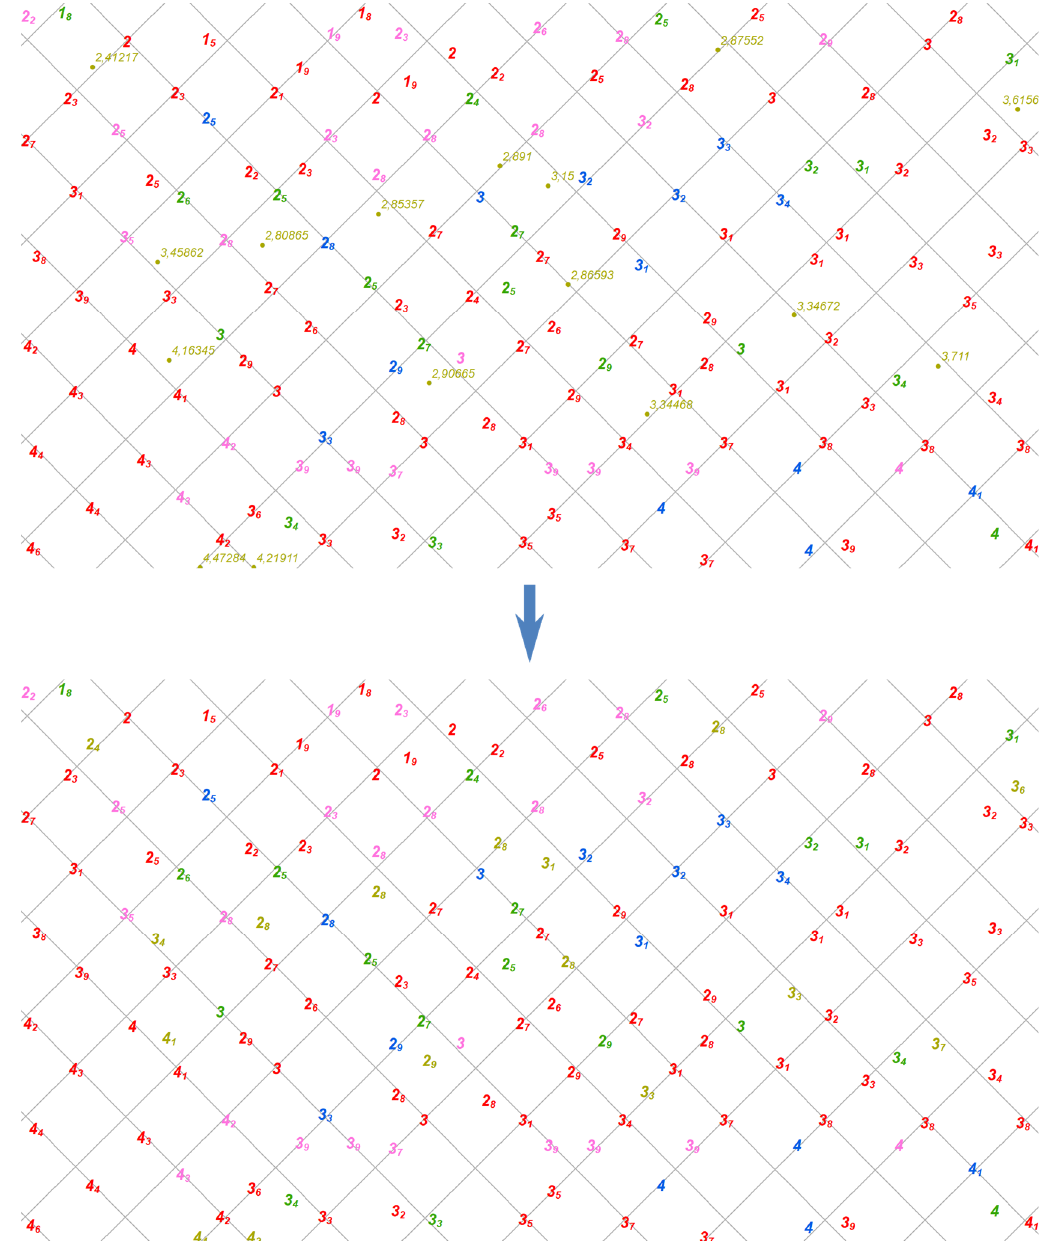
Figure 6. Fill deep soundings selection (olive—Fill deeps, green—Fill shoals, pink—Prime deeps, red—Prime shoals, blue—Background): (top image) selected soundings based on deep criteria and (bottom image) retained soundings based on distance criteria.